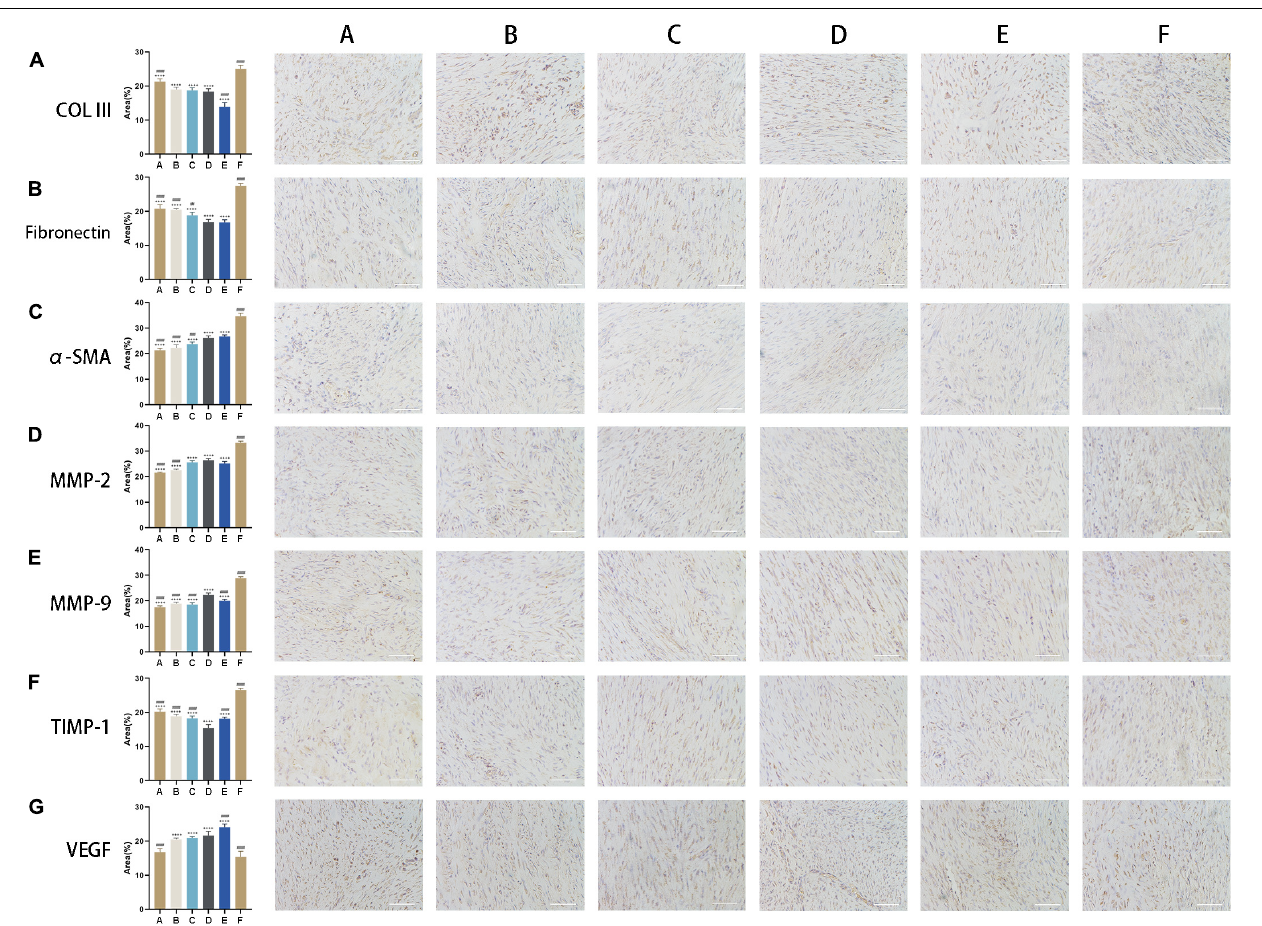
FIGURE 5 | CM alters ECM composition and promotes angiogenesis. (A,B) Expression levels of COLIII and fibronectin. With the increase of HGF concentration, their expressions decreased. (C) Expression level of α -SMA. Its expression increased following the applications of CMs. (D,E) Expression levels of MMP-2 and MMP-9. With the increase of HGF concentration, their expressions increased. (F) Expression level of TIMP-1. Its expression first decreased and then increased. The turning point came at Group D. (G) Expression level of VEGF. It was upregulated in the presence of CM, with the highest level detected in cells treated with CM6. Bars: 200 µ m. #, versus D. ## means p < 0.01, ### means p < 0.001, #### means p < 0.0001. +, versus F. ++++ means p <